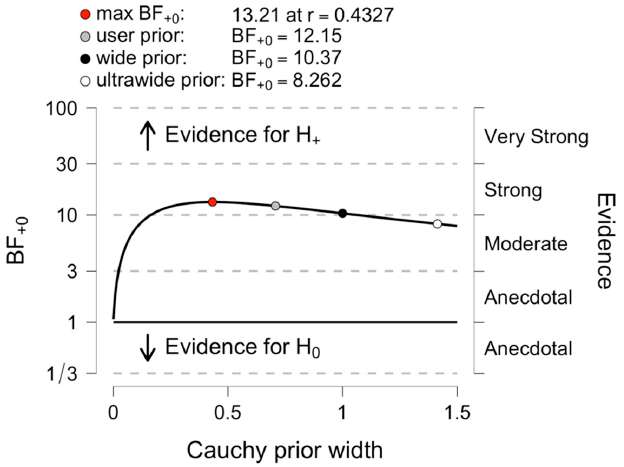
Figure A1. A Bayes factor of 12.15 suggests that the evidence provided by the data are about 12:1 in favour of the alternative hypothesis (the red part of the pie chart) that early bilinguals would demonstrate greater fluid intelligence than late bilinguals. A Bayes factor of 1 indicates that both hypotheses (alternative and null) predicted the data equally well. This prior posterior plot shows the prior (dashed line) and posterior (full line). The two gray dots indicate the prior and posterior density at the test value. The median and 95% central credible interval of the posterior distribution are shown in the top right corner. The pie chart (“probability wheel”) at the top visualises the evidence that the data provide for the two rival hypotheses (red = alternative hypothesis; white = null hypothesis).